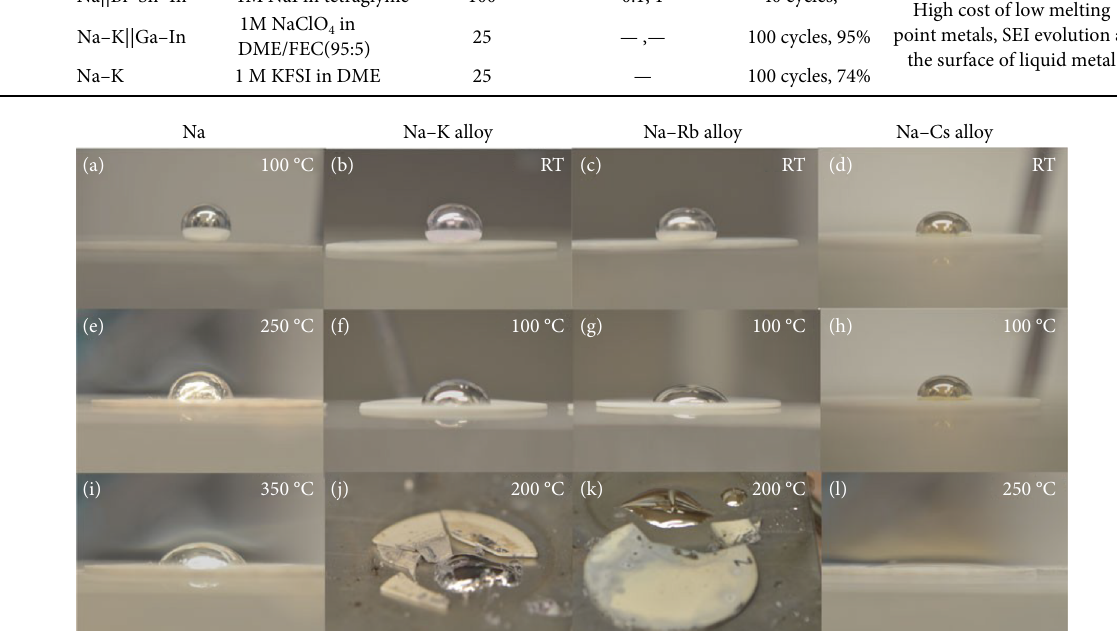
Fig. 9 Wetting behavior of Na and Na–K, Na–Rb, and Na–Cs alloys on the surface of β’’-Al 2 O 3 electrolytes. Reprinted with permission from ref. [106], © 2014 Macmillan Publishers